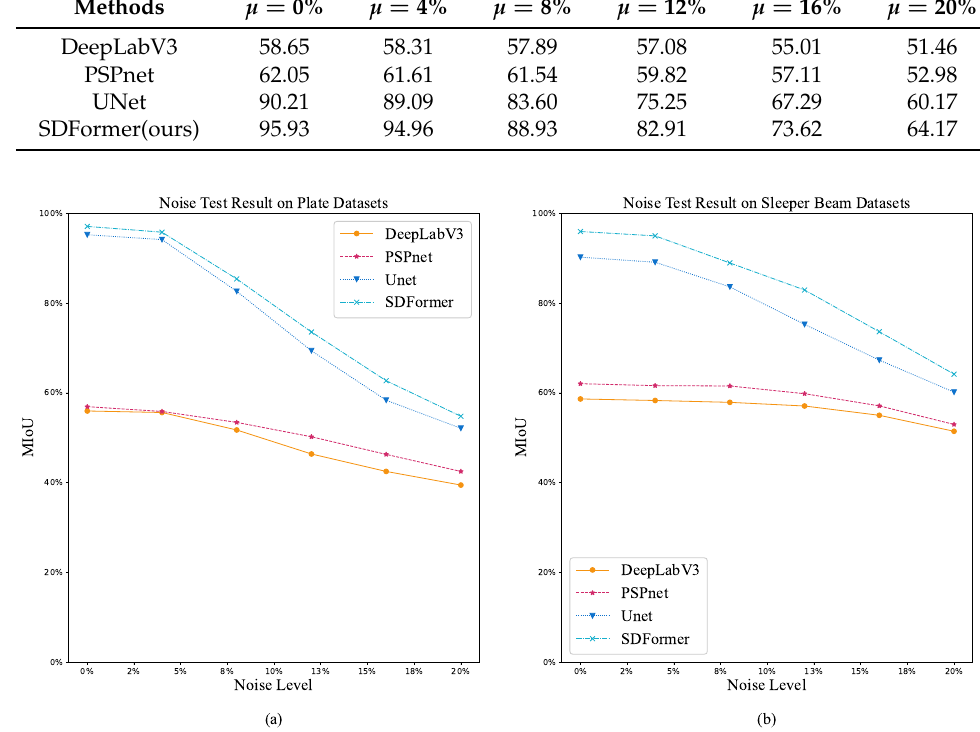
Figure 12. Anti-noise test result. ( a ) Anti-noise test result on the plate dataset. ( b ) Anti-noise test result on the sleeper beam